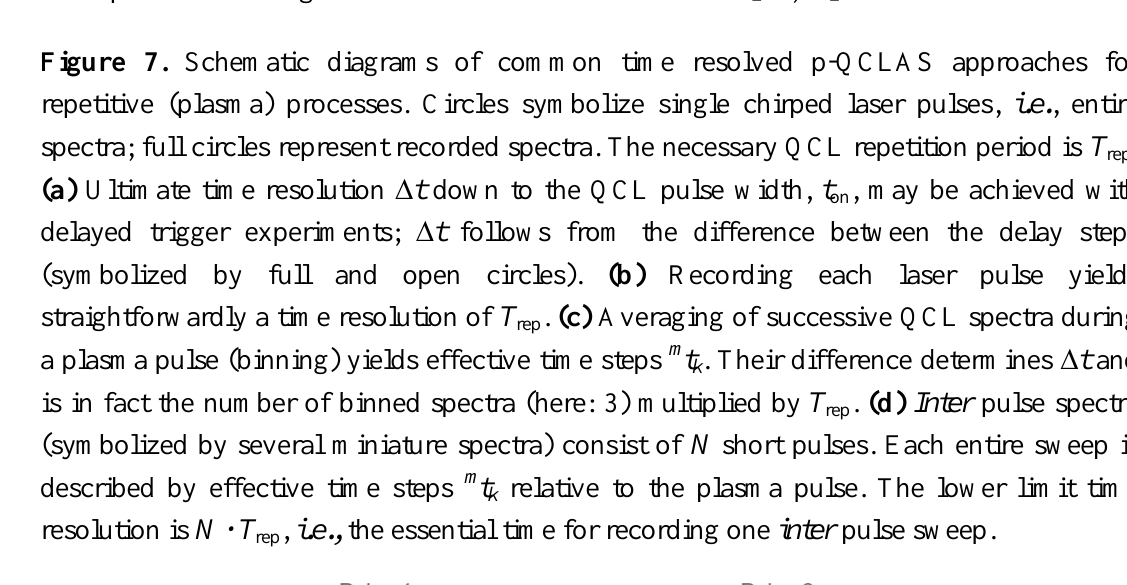
Figure 7. Schematic diagrams of common time resolved p-QCLAS approaches for repetitive (plasma) processes. Circles symbolize single chirped laser pulses, i.e. , entire spectra; full circles represent recorded spectra. The necessary QCL repetition period is T